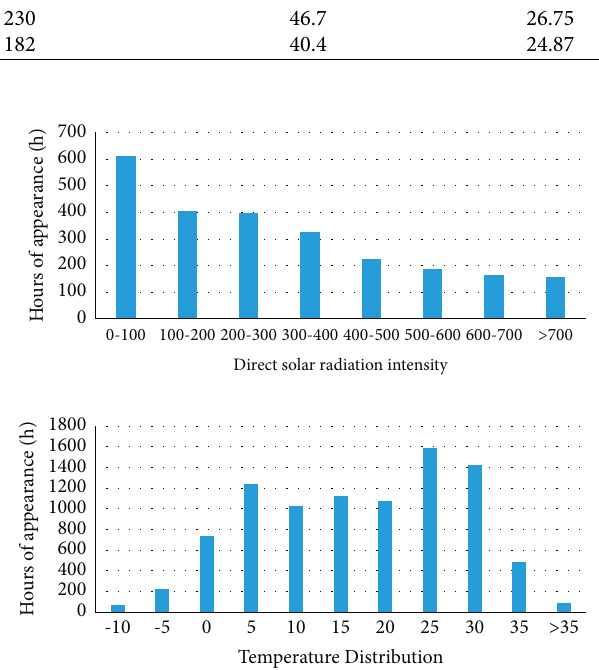
Figure 8: Statistical chart of direct solar radiation